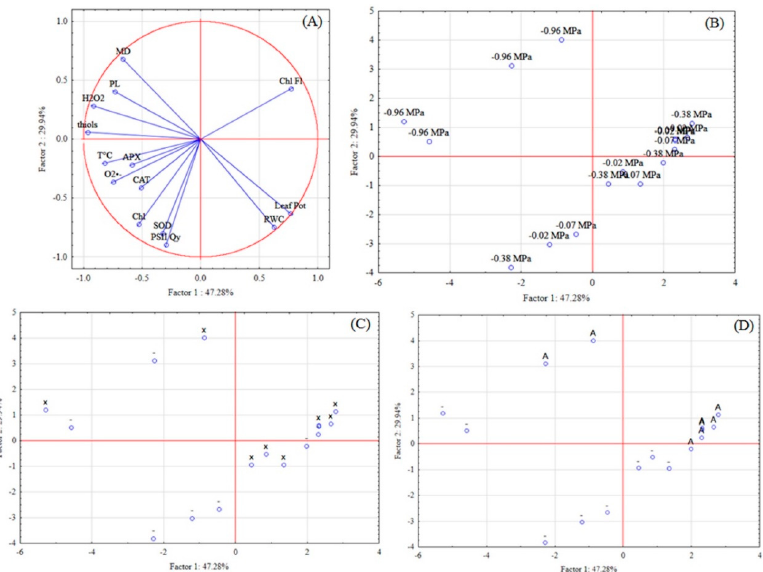
RWC, leaf water potential, H 2 O 2 , membrane damage, and thiols (Figure 7).